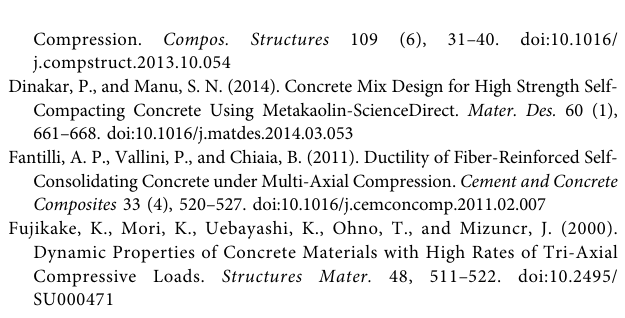
Supplementary Figure S1 | The relations between the axial load and residual load of SCC under different axial compression ratios. Supplementary Figure S2 | Biaxial compression-compression strength criterion of SCC. SupplementaryFigureS3 |Biaxialtension-compressionstrengthcriterionofSCC. Supplementary Figure S4 | Failure criterion of SCC in the plane stress space. Supplementary Figure S5 | The octahedral space stress strength criterion of SCC under biaxial